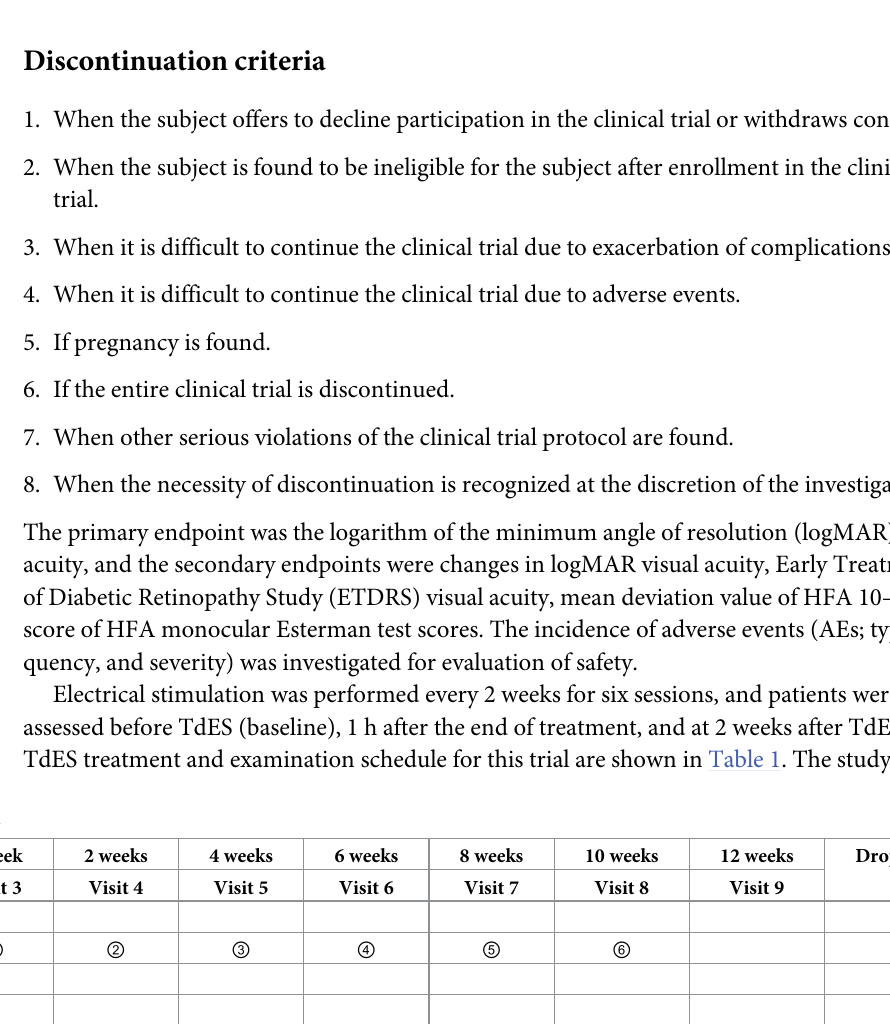
Table 1. Treatment and examination schedule. Screening